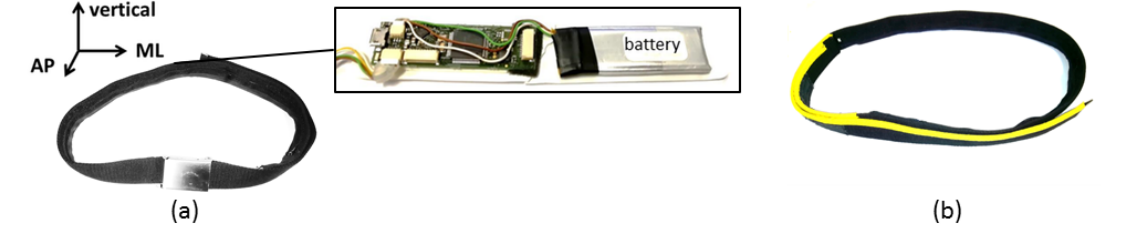
Figure 3. The applied sensor belt ( a ) in its original design with the integrated triaxial inertial sensor system and its orientation and ( b ) in its adapted form. Abbreviations: ML = mediolateral and AP =